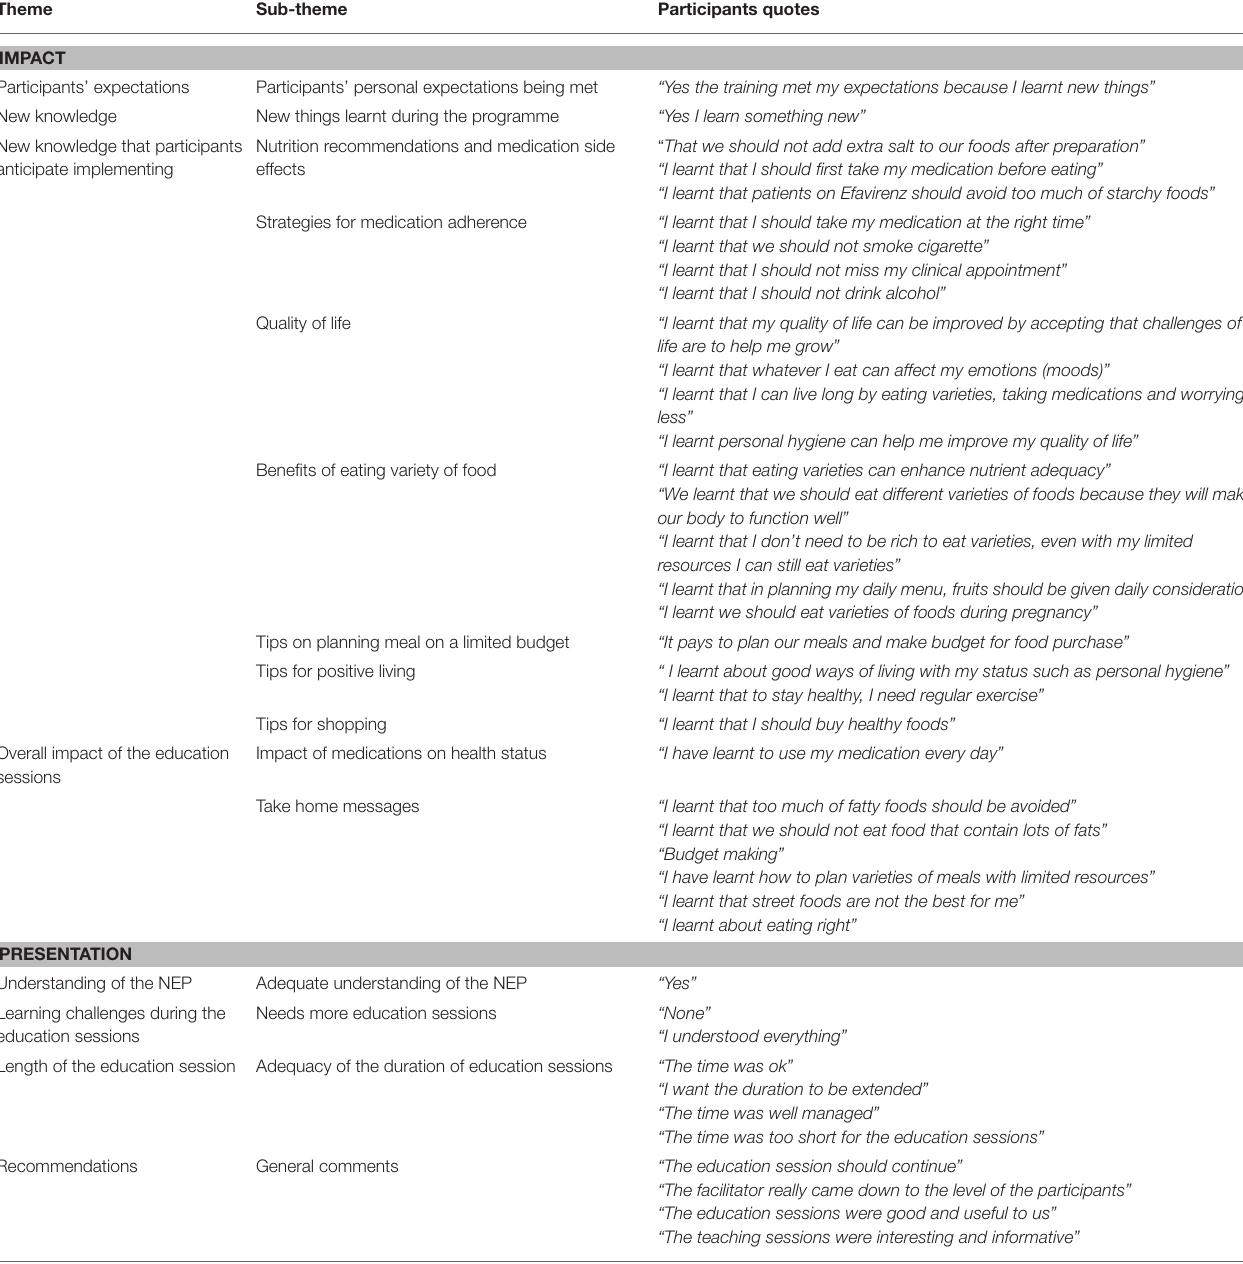
TABLE 5 | Summary of the perceptions of the participants on the impact and presentation of the nutrition education